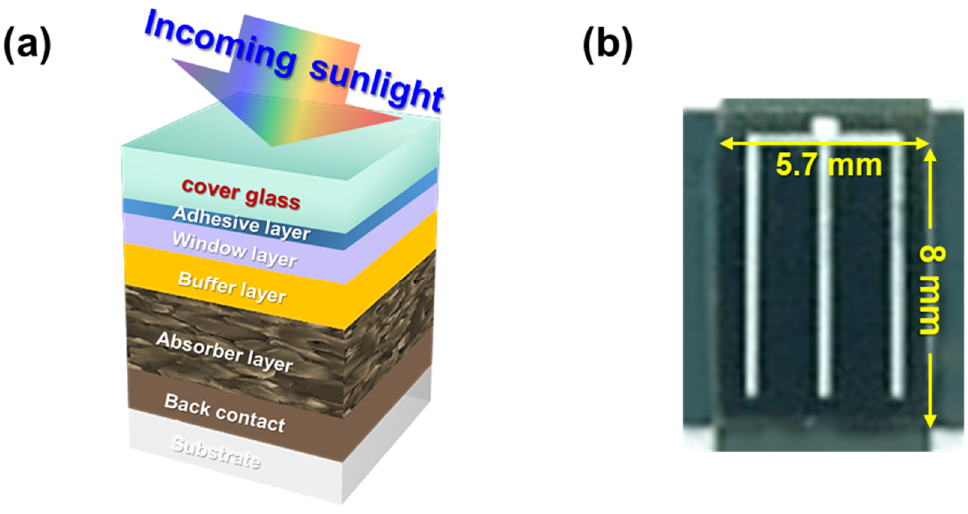
Figure 1. ( a ) Schematic diagram and ( b ) photograph of a Cu(In,Ga)Se2 (CIGS) thin film solar cell integrated with a cover glass.